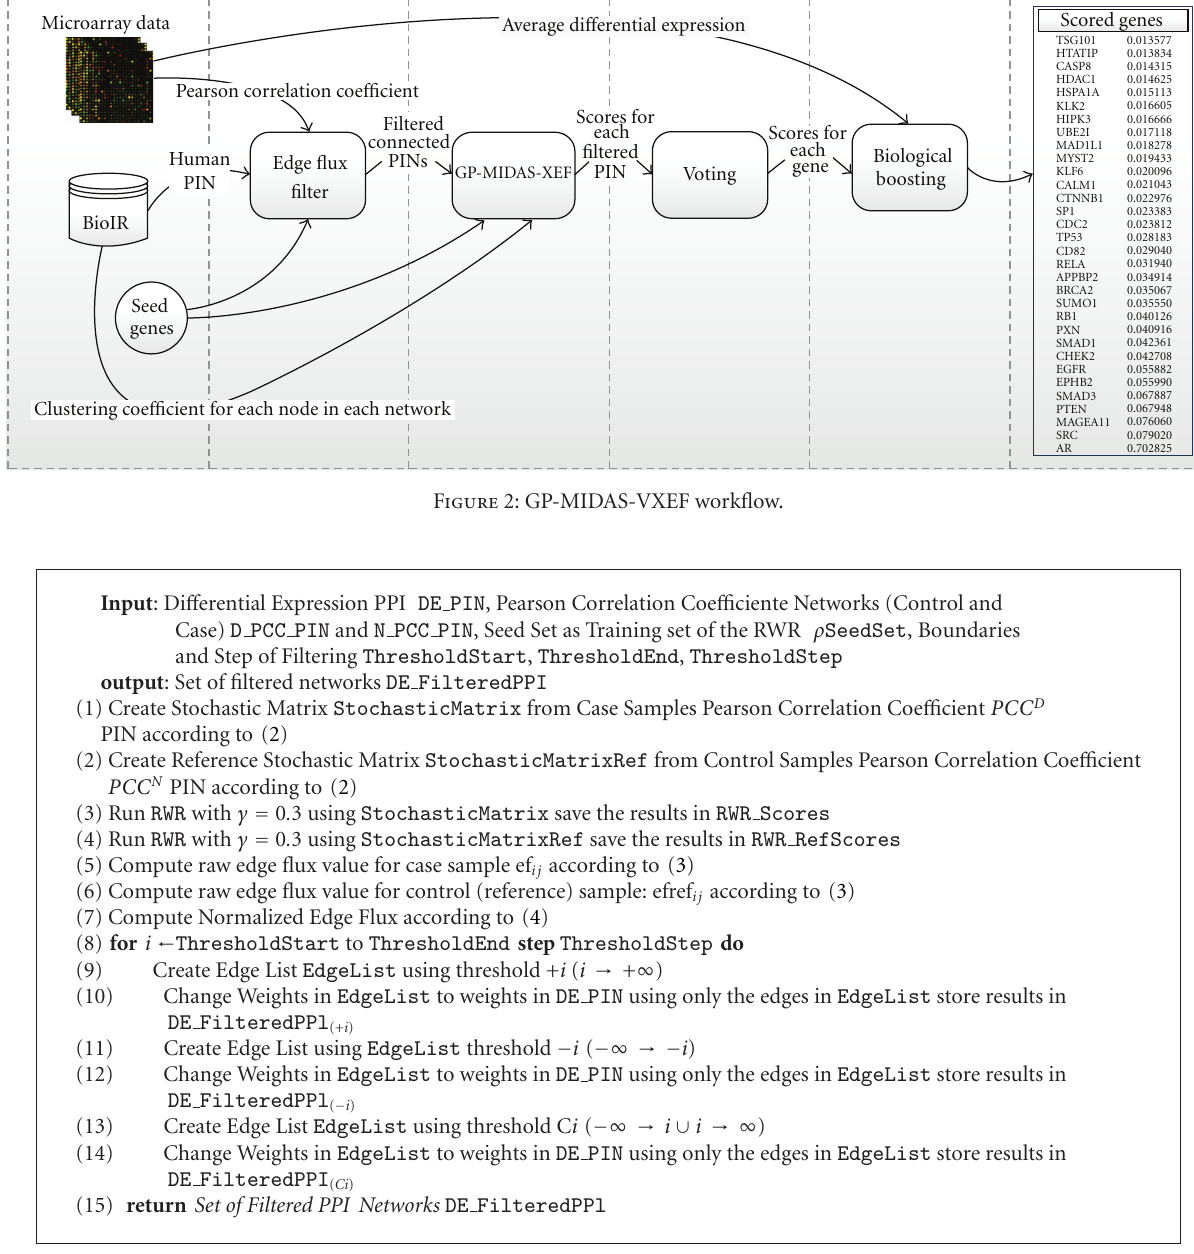
Algorithm 1: Overview of NetWalk